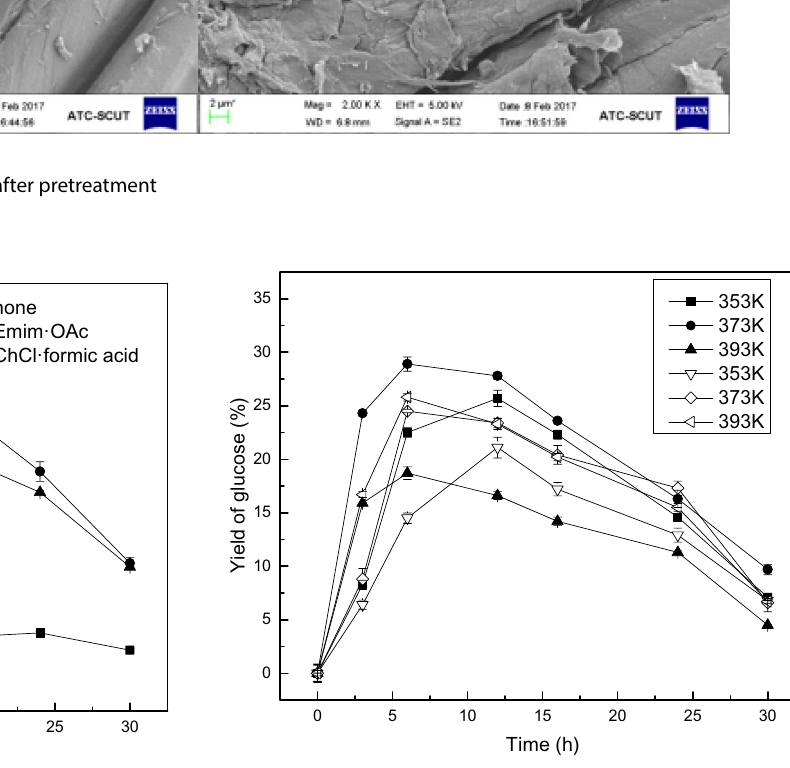
Fig. 12 One-pot hydrolysis of MCC. Reaction conditions: 0.1 g MCC, 0.1 g solid acid catalyst and 4 mL solvent, 353 K